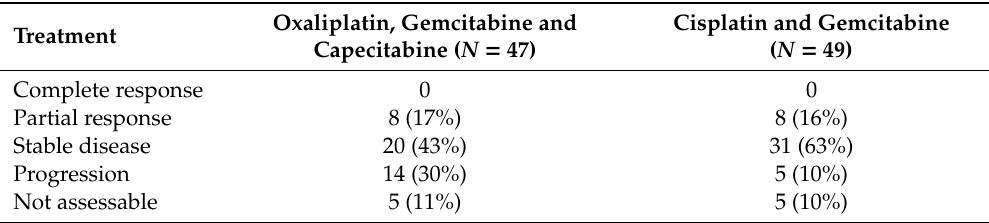
Table 2. Best tumor response in the two treatment arms evaluated by the Response Evaluation Criteria in Solid Tumors (RECIST) 1.1. Tumor control was achieved in 28 of the 47 patients (60%) in the oxaliplatin group and 39 of the 49 patients in the cisplatin group